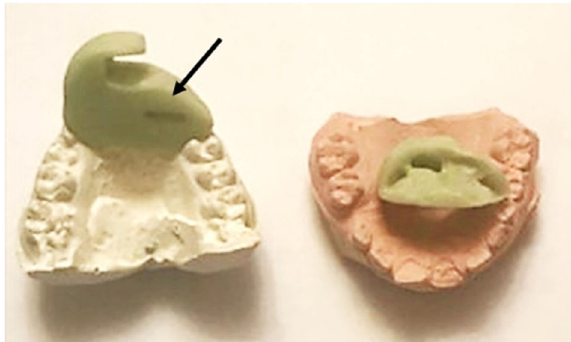
Fig. 1 Radiographic stent (acrylic bite block) and shadow of the embedded stainless-steel wire appearing.